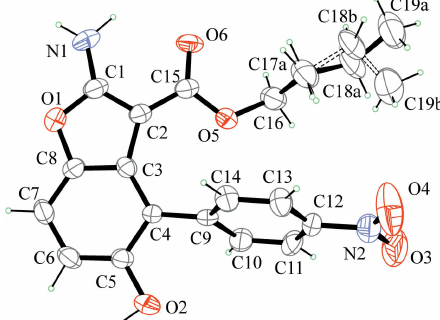
Figure 2 Molecular structure of BF1, with displacement ellipsoids drawn at the 30% probability level. The minor component of the disordered butyl group is drawn with open bonds.